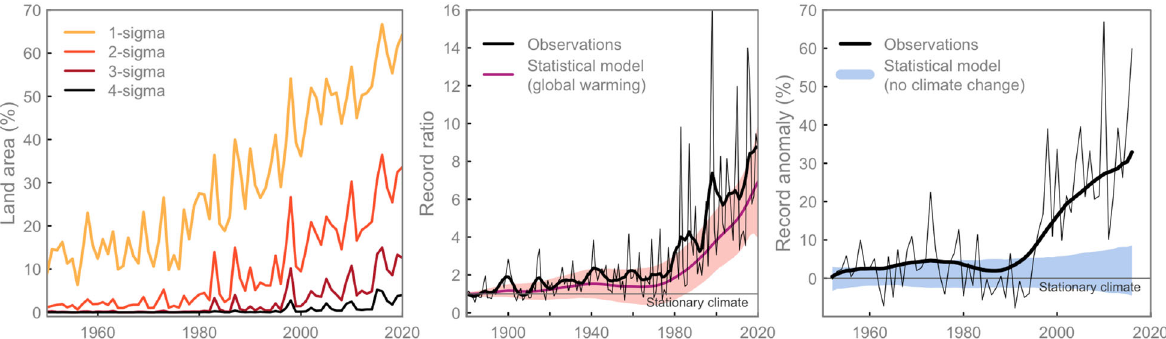
Fig. 1 Trends in climatic extremes. a Percent of the global land area with monthly temperatures above different sigma-thresholds in any calendar month (averaged over the year). b Global annual mean series (1880 − 2020) of the ratio of observed local monthly temperature records on land compared to those expected in a stationary climate. The thick black line shows the trend with a 10-yr smoothing window, and the magenta line and shading show the median and 90% con fi dence interval for the statistical model driven by the long-term global warming trend over land and Gaussian noise. c Deviation series (1950 − 2016) of the observed number of local daily-rainfall records aggregated over the year and global land areas (in percentage with respect to that expected in a stationary climate). The black line shows the long-term trend. Blue shading shows the 90% con fi dence interval for a stationary